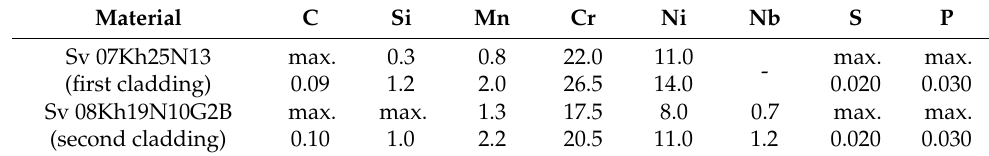
Table 1. Contents of alloying elements in individual cladding layers of WWER 440 RPV (wt. %) [10].